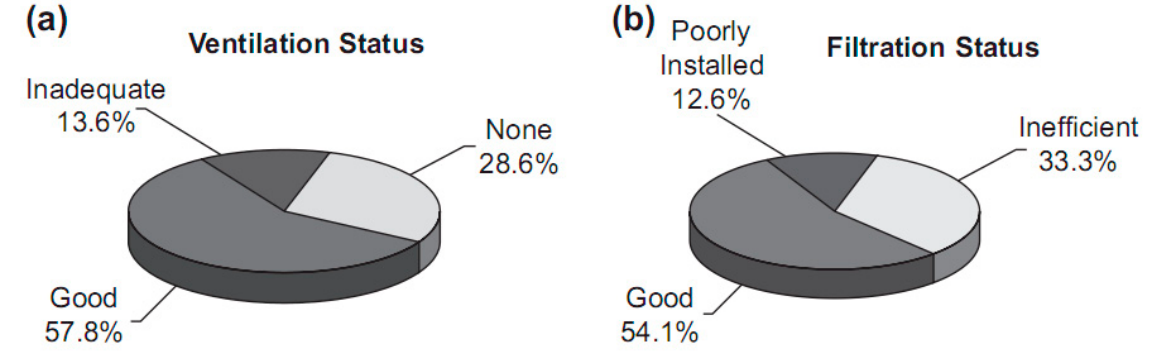
Figure 13. Rate of architectural design efficiency of the indoor environmental quality: ( a ) insufficient ventilation and ( b ) ineffective filtration (data adapted from [126]).